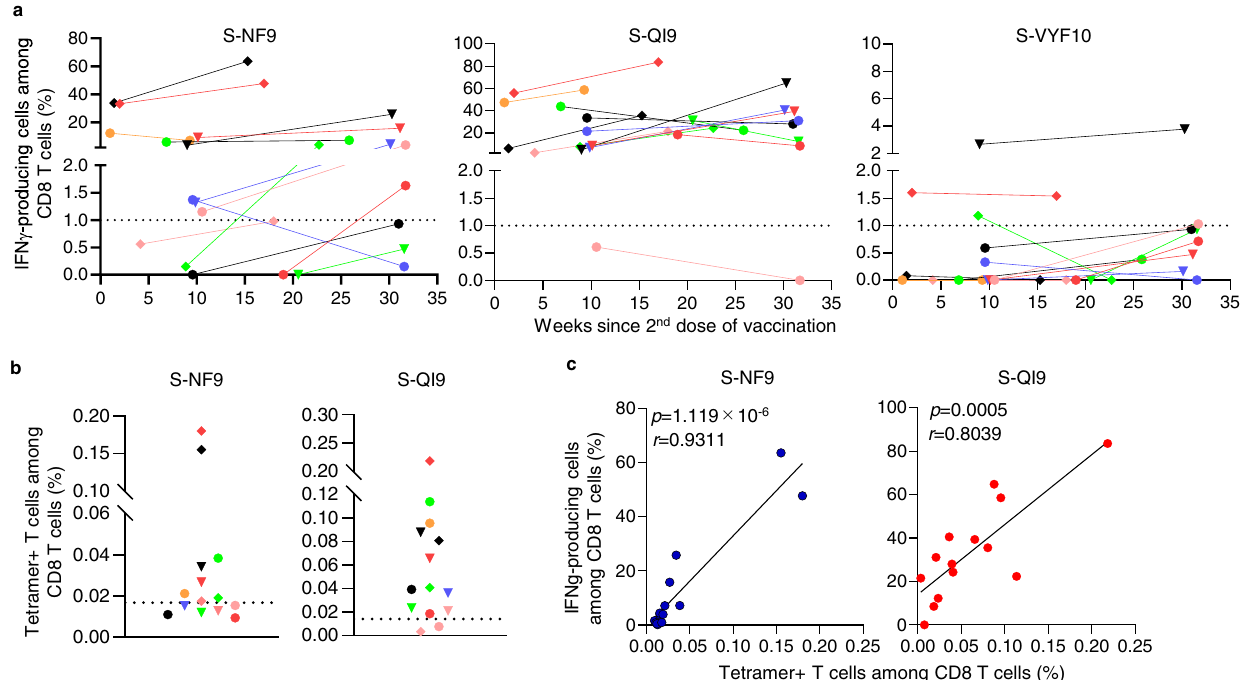
positive response. b FrequencyofHLA-A*24:02-S-NF9-tetramer + orHLA-A*24:02-S- QI9-tetramer + CD8 + T cells in ex vivo PBMCs from 14 HLA-A*24:02 + individuals correspondingtothesamplesusedin fi gurepanela.Thedottedlinerepresentsthe threshold for positive binding. c Correlation between the frequency of tetramer- binding CD8 + T cells and that of IFN- γ -producing cells. Statistical analyses were performed using two-tailed Pearson ’ s correlation test. Gating strategy in fl owcy- tometry analysis is shown in Supplementary Fig. 1a (ICS assay) and Supplementary Fig. 2a (tetramer binding). Source data are provided as a Source Data fi